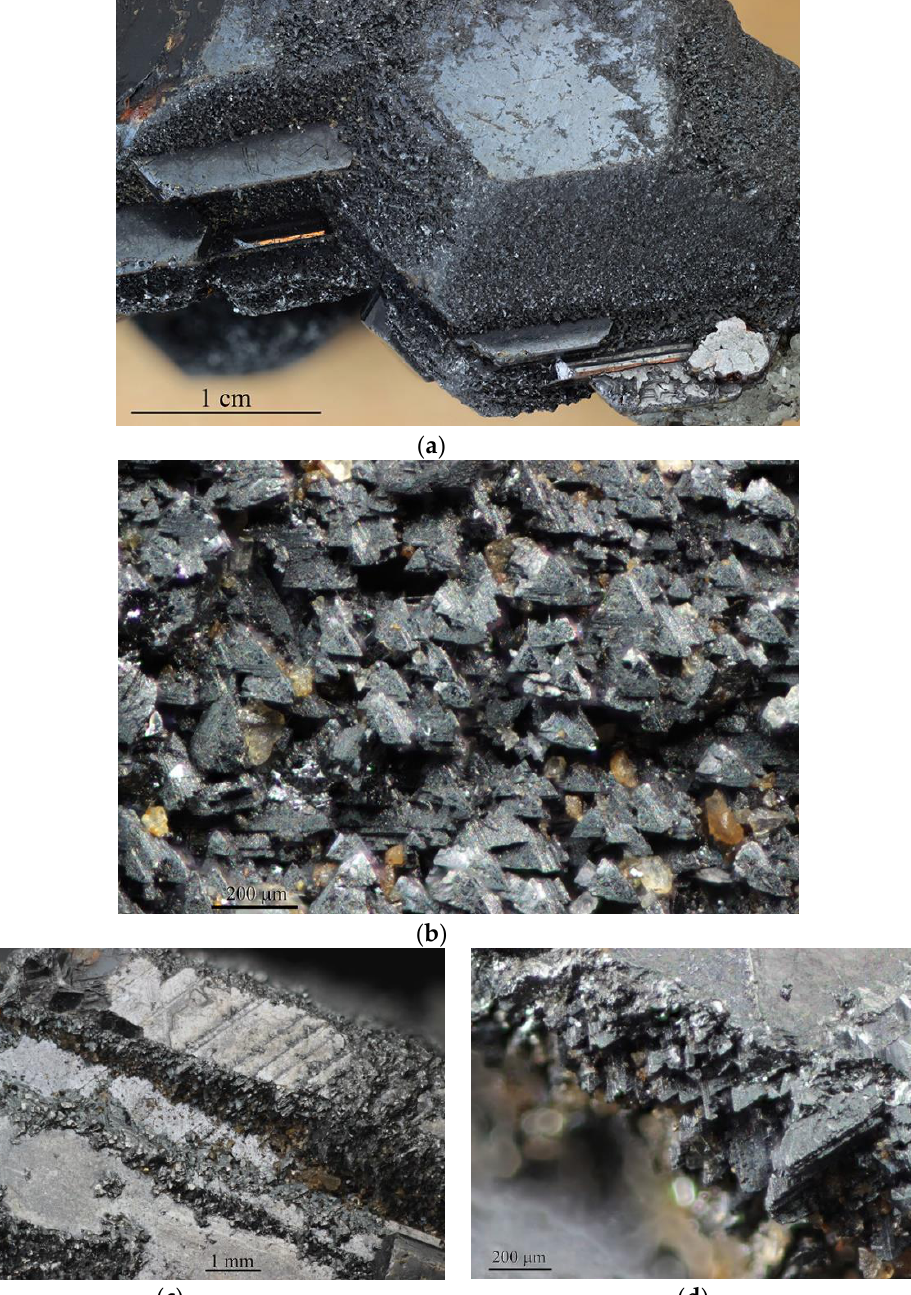
Figure 1. ( a ) Richardsite coating a wurtzite–sphalerite crystal cluster with oriented terraces of secondary sphalerite crystals (not coated by richardsite). Minor diopside is present at the lower right. ( b ) Nearly parallel growth of richardsite crystals showing disphenoidal forms with stepped surfaces. ( c , d ) Apparent epitaxic overgrowth of richardsite on selective facets of primary wurtzite–sphalerite crystals.